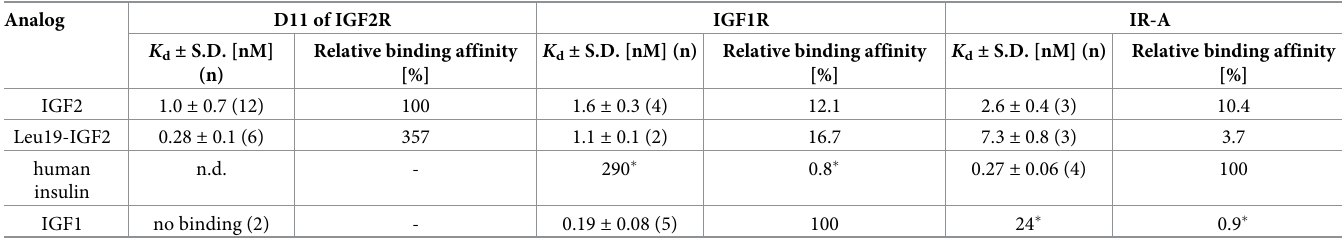
IGF1 no binding (2) The K d values and relative binding affinities were calculated from at least three independent measurements. (n) is number of replicates. Relative binding affinity is defined as K d of native hormone/ K d of analog x 100. � Data from Ref.